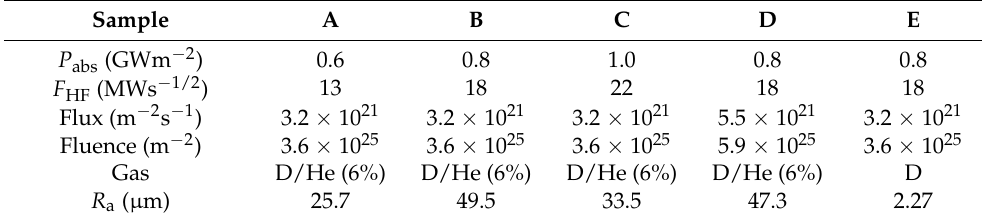
Table 1. Summary of the plasma and thermal shock treatments applied to ITER-grade tungsten samples and the resulting average arithmetic roughness ( R a ) of the